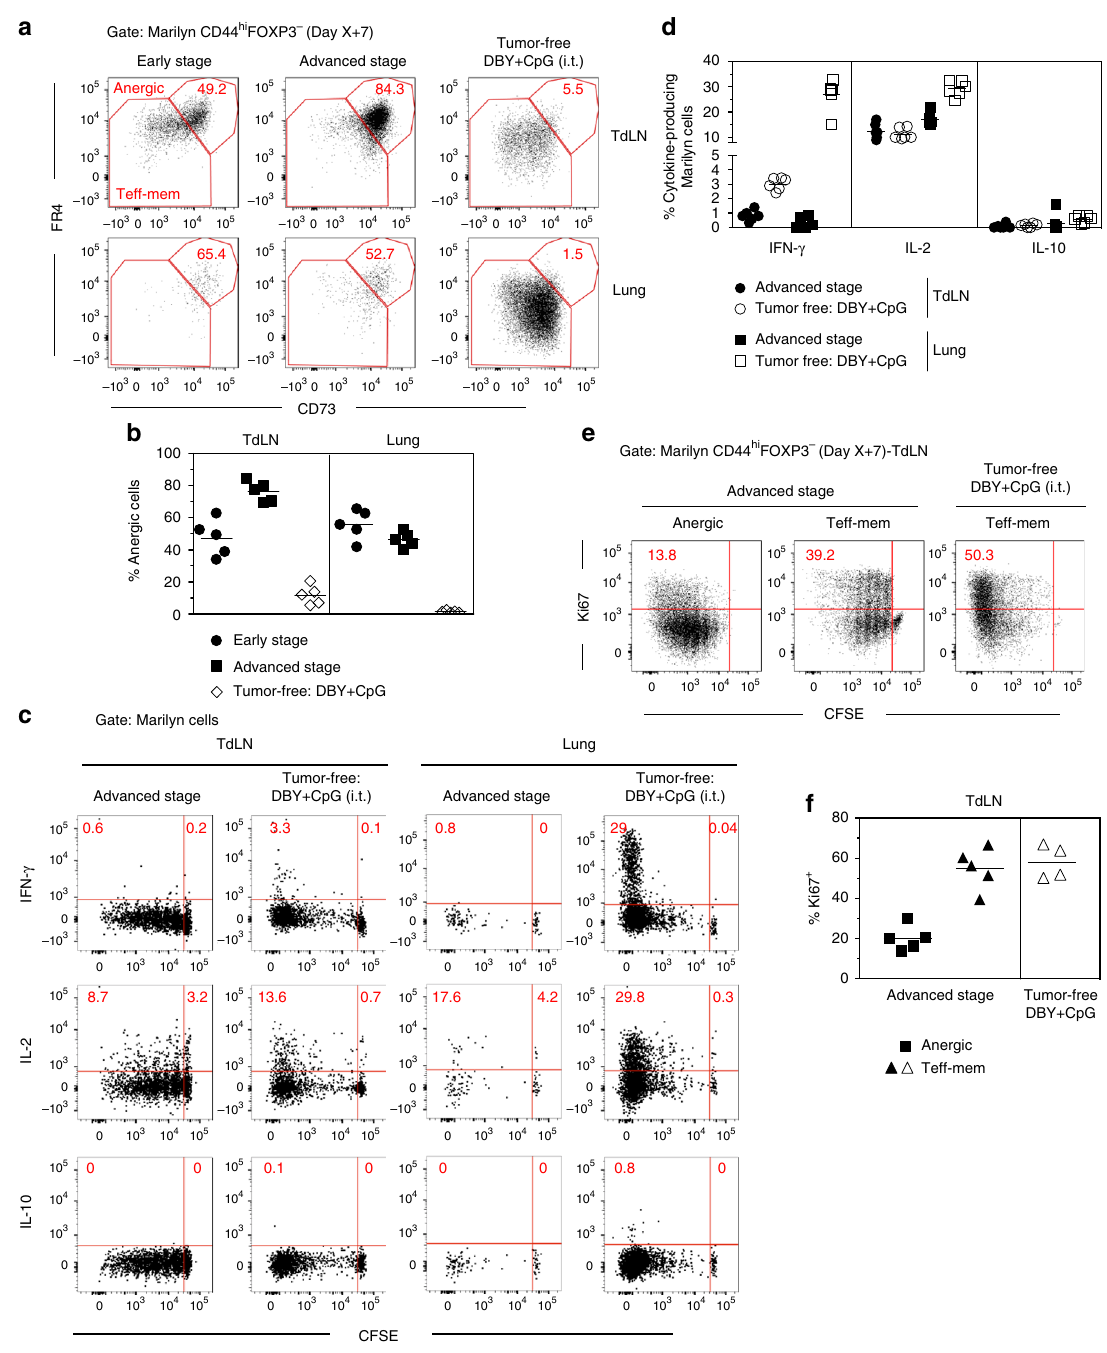
Fig. 3 Most of activated tumor Ag-speci fi c CD4 + T cells becomes anergic. a CD73 and FR4 expression by CD44 hi FOXP3 - Marilyn cells in tumor-bearing mice or tumor-free B6 mice inoculated with DBY + CpG (i.t.); b frequency of FR4 hi CD73 hi (anergic) Marilyn cells. c , d Marilyn cells were harvested 7 days after transfer from TdLNs or lung of mice bearing advanced tumors. Cells were restimulated in vitro with CD3 ε -/- female splenocytes pulsed with DBY peptide (10 nM). Controls were tumor-free mice i.t. injected with DBY + CpG. c Representative IFN- γ , IL-2 and IL-10 production by Marilyn cells according to cell division. d Quanti fi cation (frequency) . e Representative Ki67 expression by anergic and effector cells in tumor-bearing or tumor-free mice. f Quanti fi cation (frequency). One representative experiment out of three is